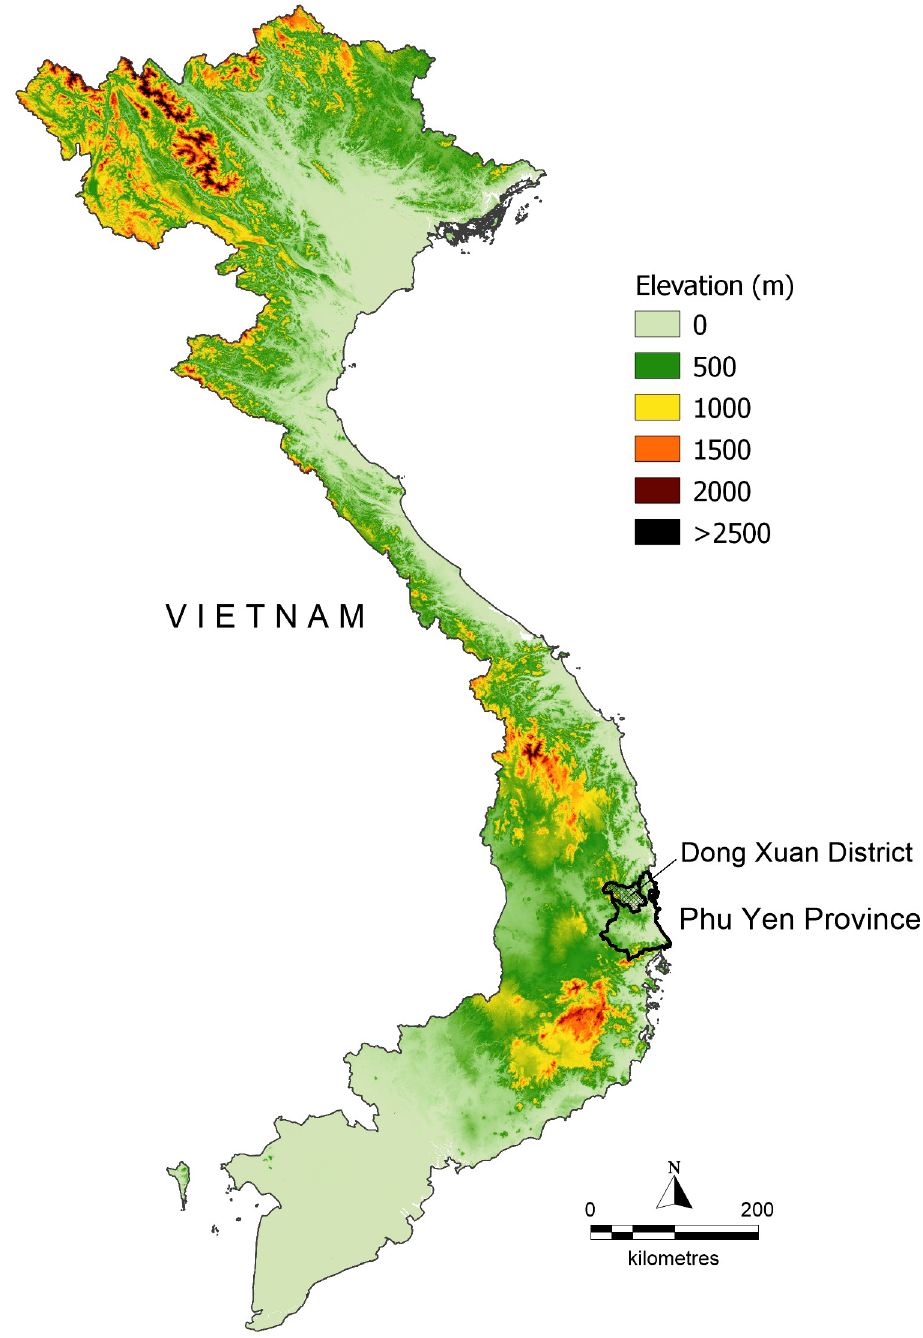
Fig 1. Study site location map highlighting major mountain ranges in Vietnam. Custom map produced by the authors using MapInfo Professional v15 . 0 . 2 (Pitney Bowes Software Inc. 2015, Stamford, CT; https://www.pitneybowes.